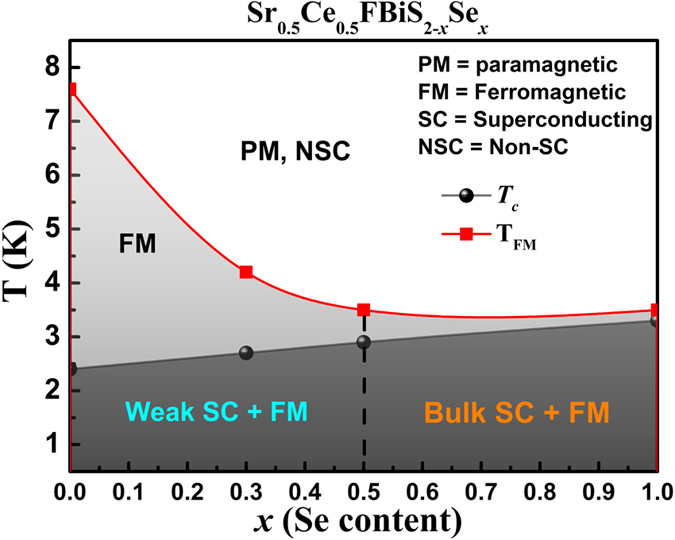
Ferromagnetism and superconductivity phase diagram of Sr0.5Ce0.5FBiS2-xSex (0 ≤ x ≤ 1).